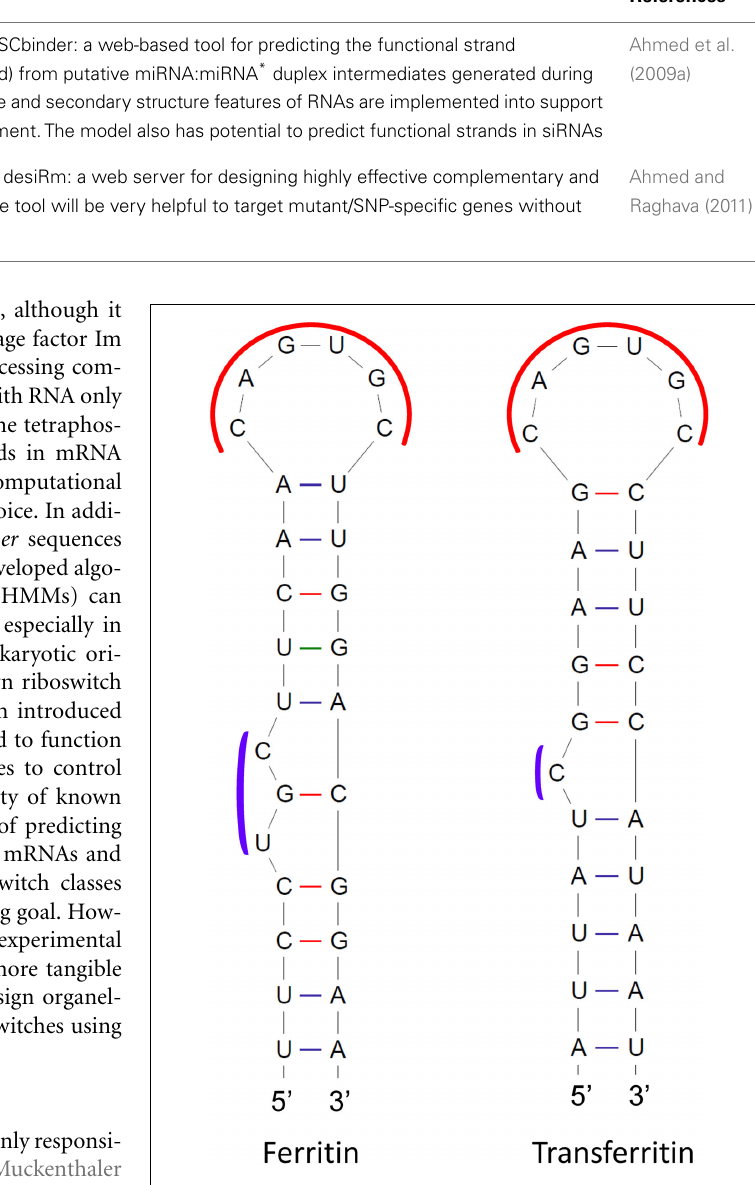
FIGURE 4 | Structures of iron-responsive elements (IREs) in mRNAs encoding human ferritin and transferrin receptor proteins. Conserved regions are shown in red and blue